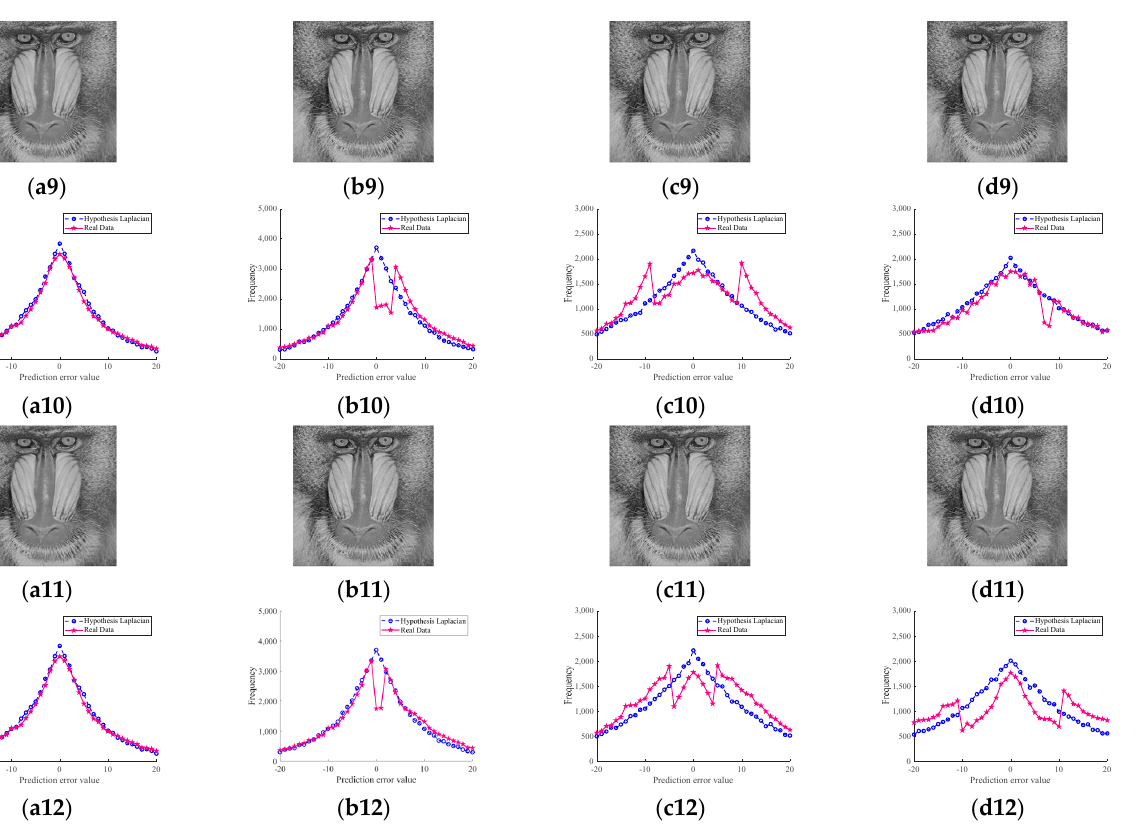
Figure 11. Comparison of the after-embedding prediction error histograms with proposed trace concealment algorithm, traditional HS algorithm, and the skipping HS algorithm: ( a1 ) Original image; ( b1 ) Stego images by the proposed (ER = 0.1 bpp, PSNR = 51.33 dB); ( c1 ) Stego images by the proposed (ER = 0.4 bpp, PSNR = 45.26 dB); ( d1 ) Stego images by the proposed (ER = 0.7 bpp, PSNR = 39.29 dB); ( a2 ) Histogram of (a1); ( b2 ) Histogram of (b1); ( c2 ) Histogram of (c1); ( d2 ) Histogram of (d1); ( a3 ) Original image; ( b3 ) Stego images by traditional HS (ER = 0.1 bpp, PSNR = 52.38 dB); ( c3 ) Stego images by traditional HS (ER = 0.4 bpp, PSNR = 45.80 dB); ( d3 ) Stego images by traditional HS